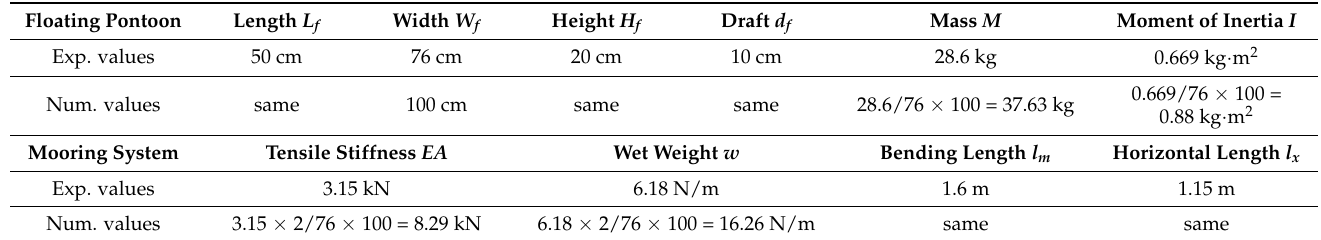
Table 1. Parameters of the cuboid floating pontoon and its mooring